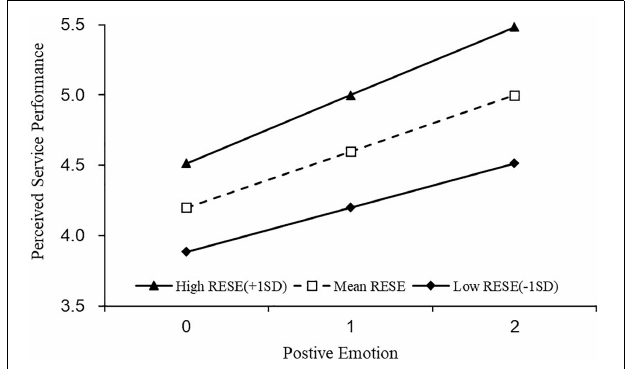
for both low RESE ( b = 0.314, t = 7.609, p < 0.01 and high RESE employees ( b = 0.485, t = 19.131, p < 0.01), but the effect was significantly higher for high RESEs than that for low RESEs ( b high = 0.485, 95% CI = [0.435, 0.534] vs. b low = 0.314, 95% CI = [0.233, 0.395]) (see Figure 2 ).